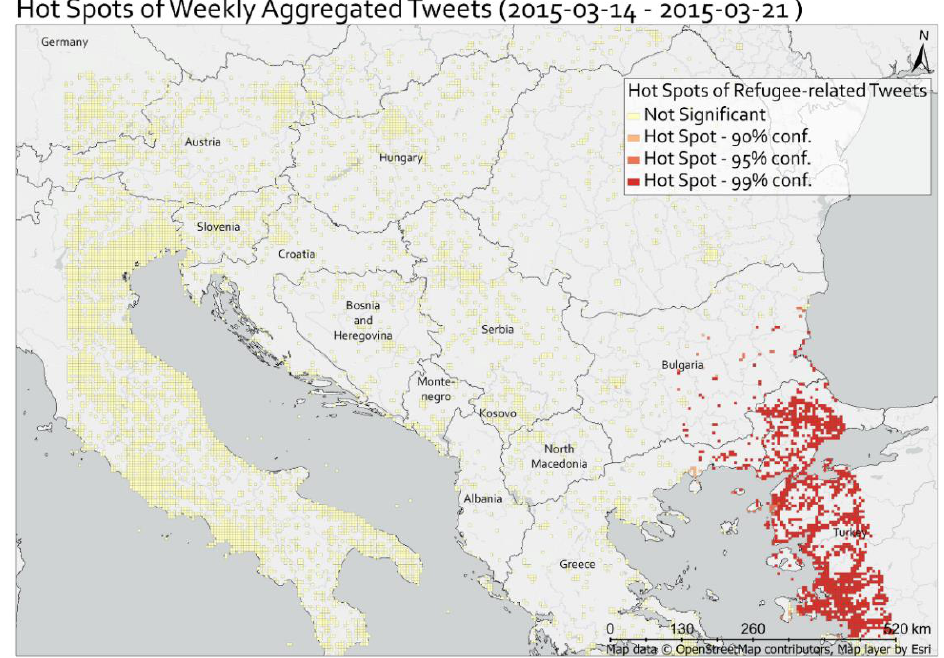
Figure 15. Weekly hot spots of aggregated relevant tweets from 14 March 2015–21 March 2015. Reprinted from map